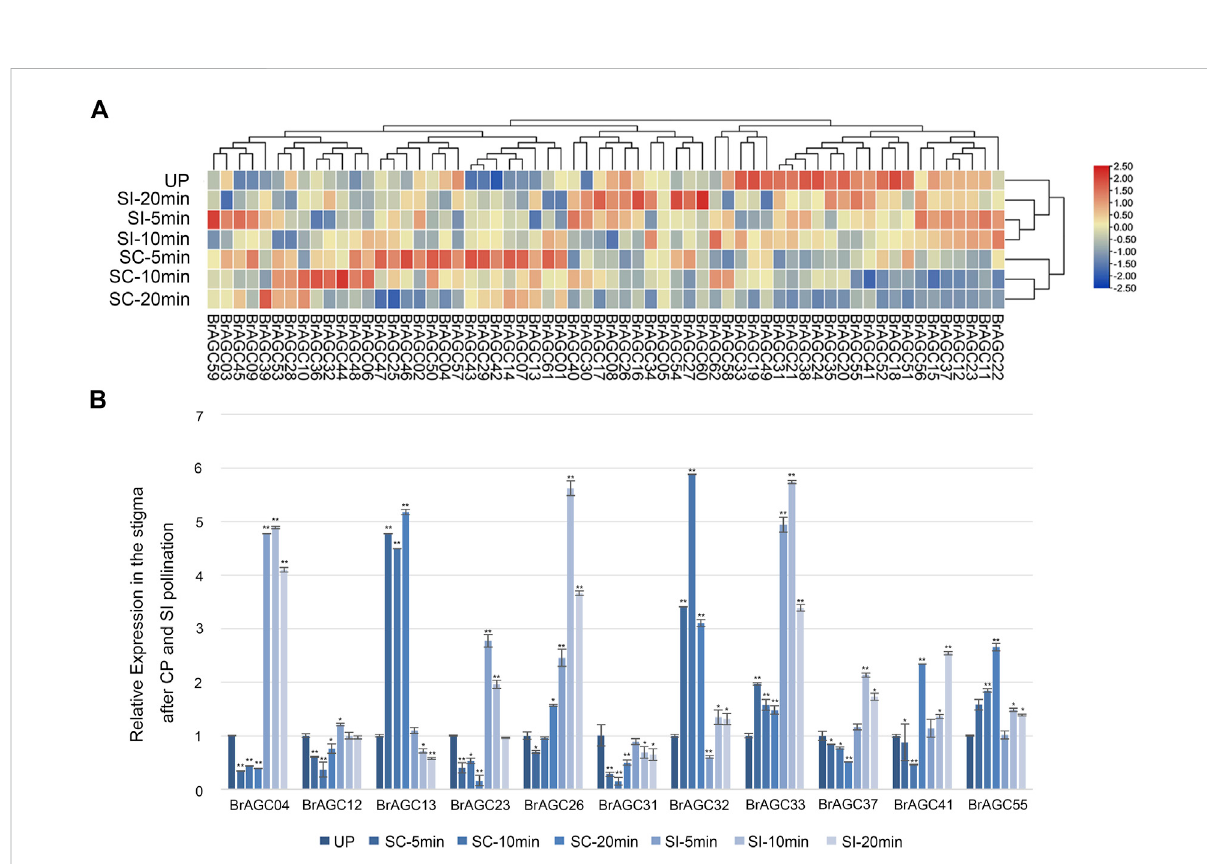
FIGURE 7 Expression pro fi les of BrAGC genes during the SI and CP response. (A) Heatmap showing the expression patterns of BrAGC genes in the UP stigmaandunderCPandSIpollinationafter5,10,and20 min. (B) Transcriptionalexpressionpatternsof11 BrAGC genesinthestigmaafterCPandSI pollination at 5, 10, and 20 min. The above experiments were performed using UP as the control; each group was subjected to three biological replicates, and error bars indicate standard errors. Asterisks above data bars indicate statistical signi fi cance (two-tailed t -test; * p < 0.05; ** p <